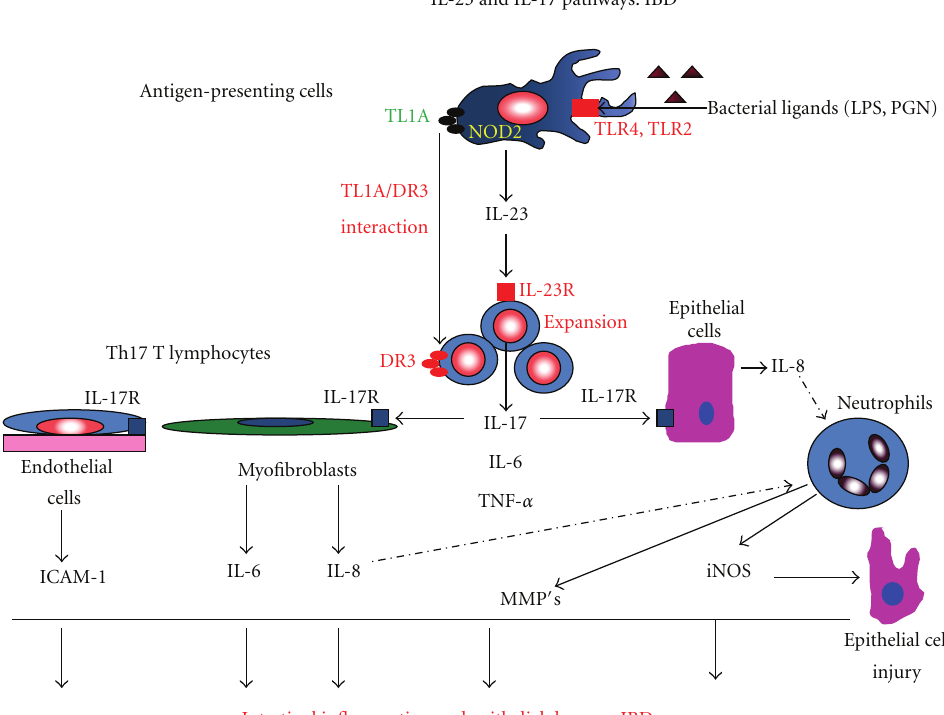
Figure 1: This figure shows relevant cell types, mediators, and potential pharmacological targets associated with IL-23 and IL-17 pathways (IL-23/IL-17 Axis), which are operative within the context of inflammatory bowel disease (IBD). Bacterial ligands (lipopolysaccharide [LPS] and peptidoglycan [PGN]) bind to their respective toll-like receptors (TLR4 and TLR2) and induce IL-23 release from antigen-presenting cells (APC’s). IL-23 binds to the IL-23 receptor (IL-23R) to stimulate expansion of Th-17-producing cells, which release IL-17. In addition, interactions between TL1A (tumor necrosis factor-like molecule) on APC’s and DR3 (death receptor 3) on T lymphocytes induces the secretion of IL-17. These pathways also promote the secretion other proinflammatory cytokines like IL-6 and TNF- α . IL-17 stimulates the expression of adhesion molecules (e.g., ICAM-1) on endothelial cells, as well as the release of IL-6 and IL-8 from myofibroblasts and epithelial cells. IL-8 acts as a chemotactic factor for neutrophil influx into the intestine. Infiltrating neutrophils release inflammatory mediators like matrix metalloproteinases (MMP’s) and inducible nitric oxide synthase (iNOS). This sequelae of pathogenic events leads to the chronic inflammation and epithelial cell damage associated with